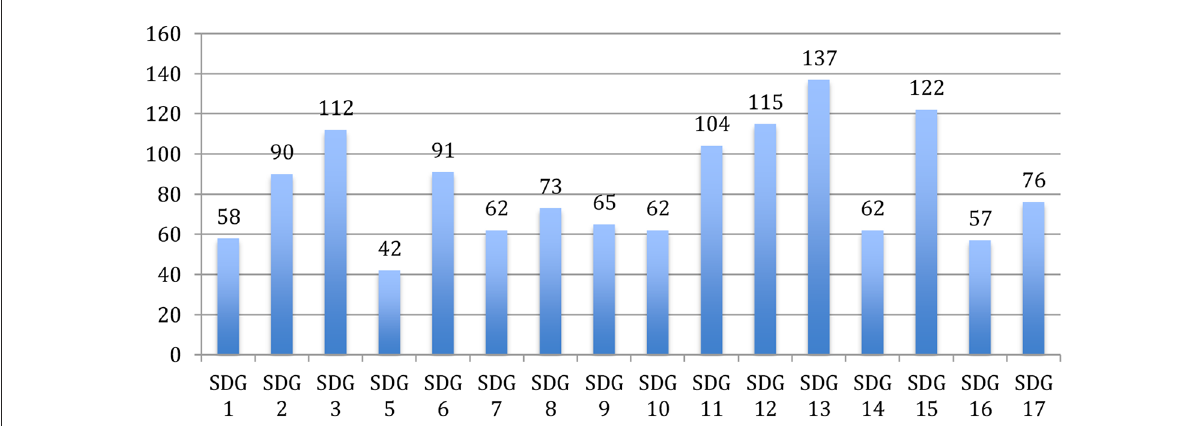
FIGURE5 RCE project reports tagged by Sustainable Development Goal (SDG), omitting SDG 4 (Quality Education) during the GAP (2015–2019). n > 479, as RCEs were able to tag more than one Sustainable Development Goal (SDG) if the RCE project incorporated more than one. For example,